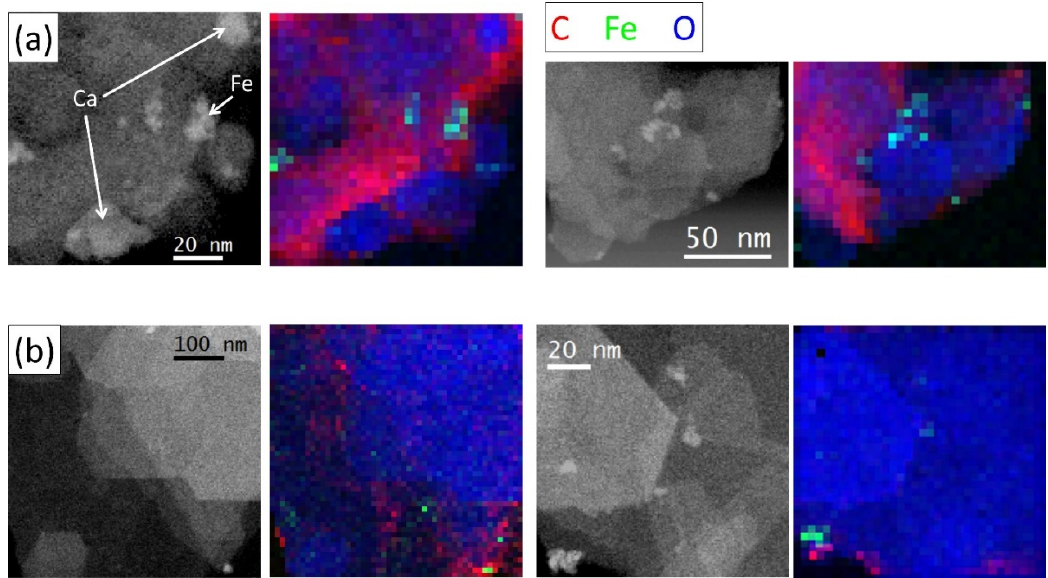
Figure 8. High-resolution ADF-STEM images and EELS elemental maps for three elements (C, Fe, and O) acquired on ( a ) biwettable and ( b ) hydrophilic <200 nm clay platelets. The RGB contrast consists of: red = carbon, green = iron, and blue = oxygen.